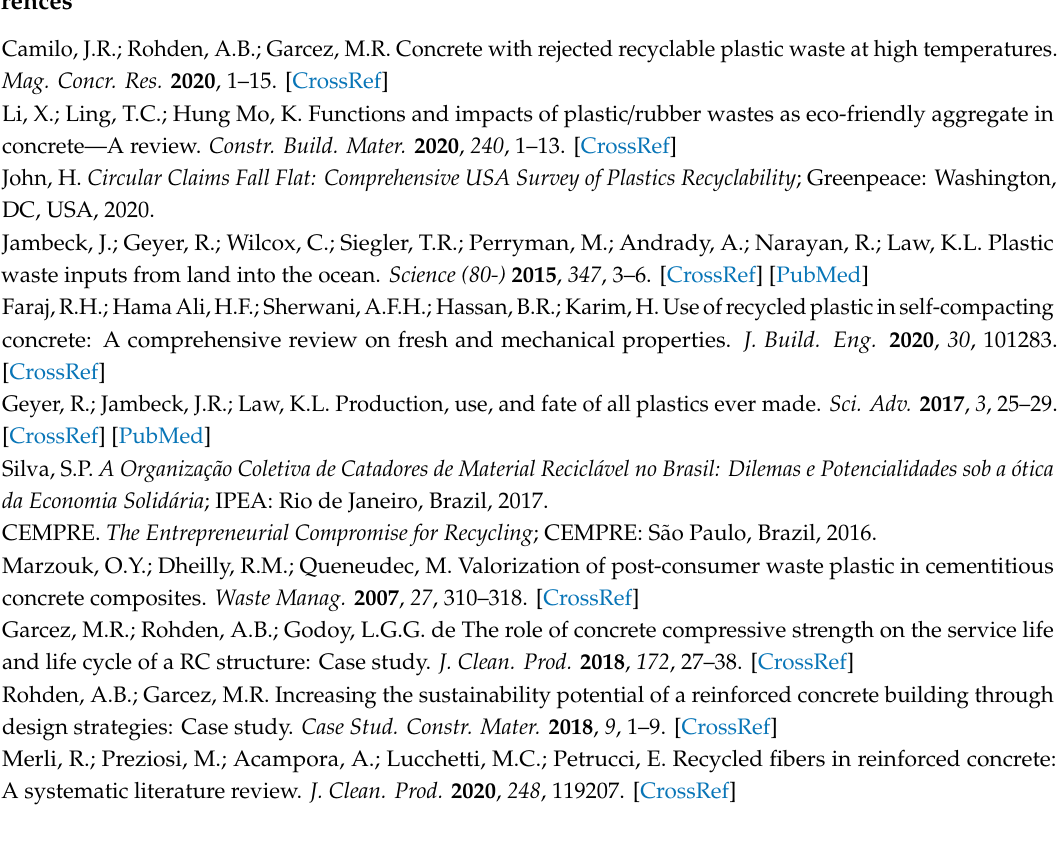
Figure S1: SEM images of Figure 7 without anaglyph e ff ect: (a) Reference concrete matrix; (b) PP fiber in concrete matrix; (c) PW in concrete